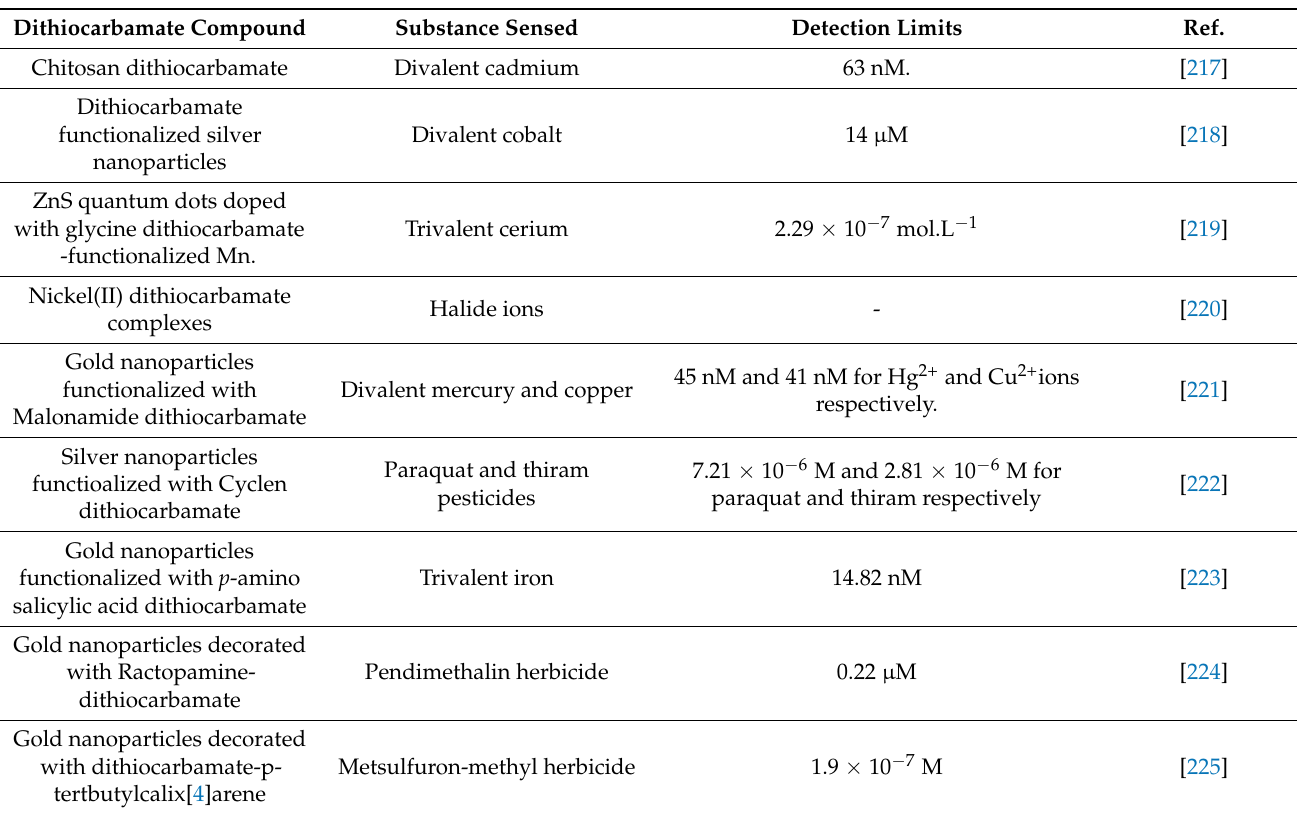
Table 7. Application of dithiocarbamates in